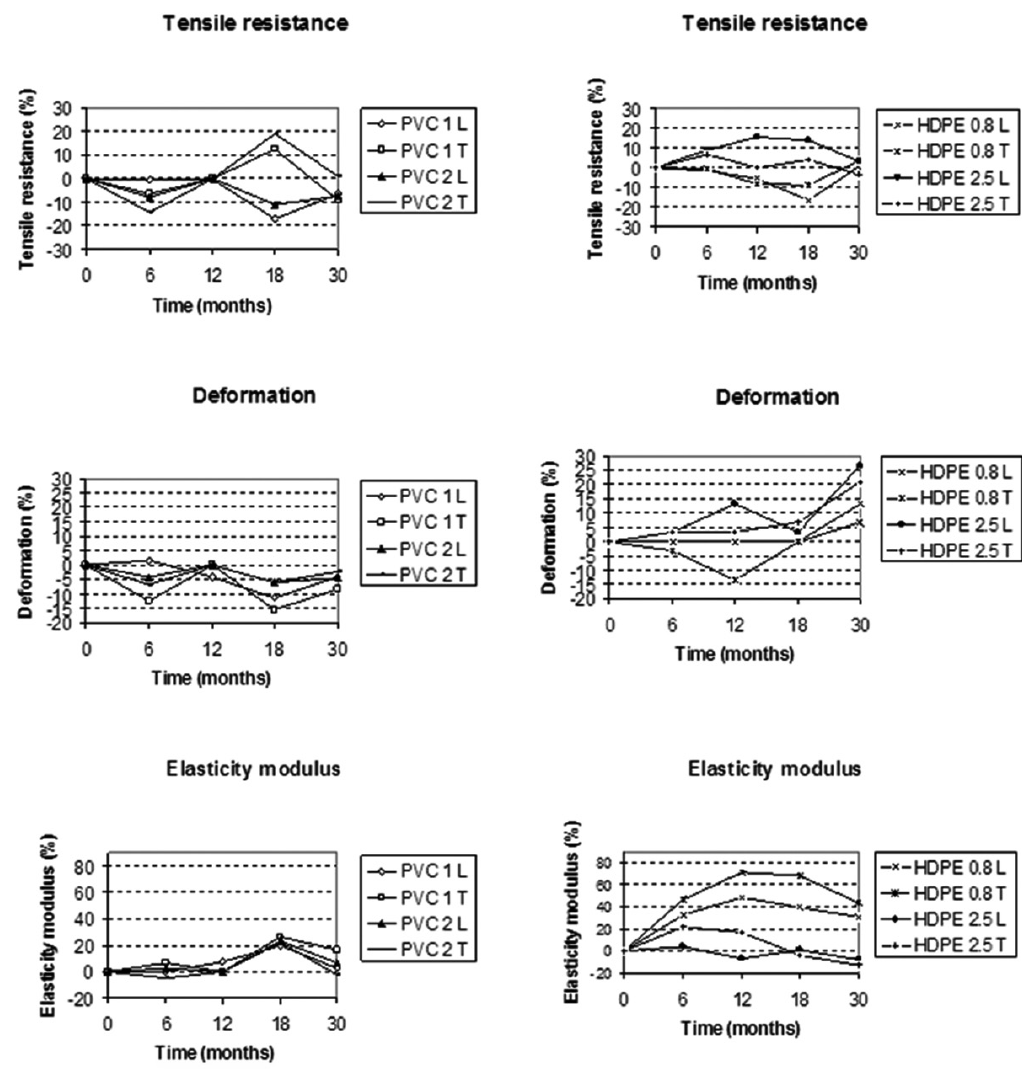
Figure 2. Effects of weathering exposure on mechanical properties after 30